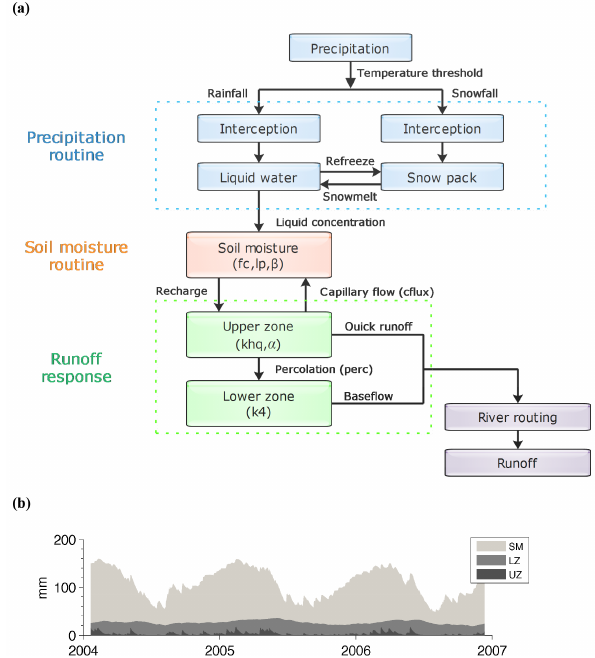
Figure 2. (a) OpenStreams wflow_hbv model structure, adapted from Schellekens (2014). (b) Sample results of the nominal run related to soil moisture (SM), upper groundwater zone (UZ), and lower groundwater (GW) zone (LZ) storages averaged over Rhine River